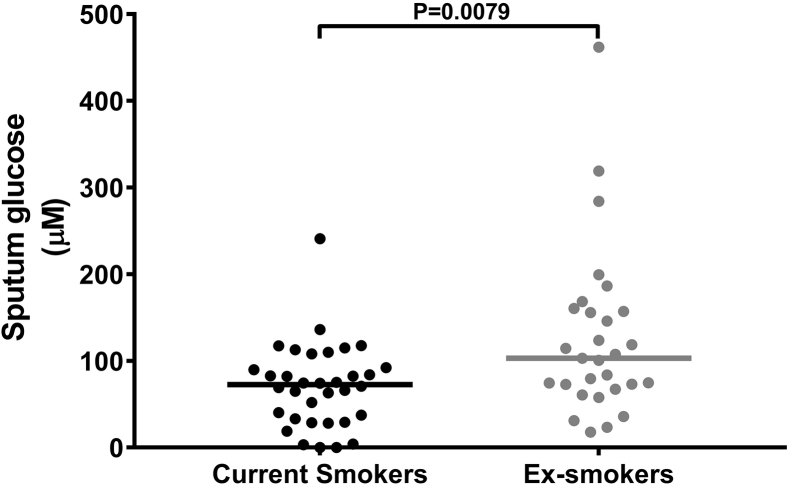
Sputum glucose concentrations according to smoking status in patients with COPD.